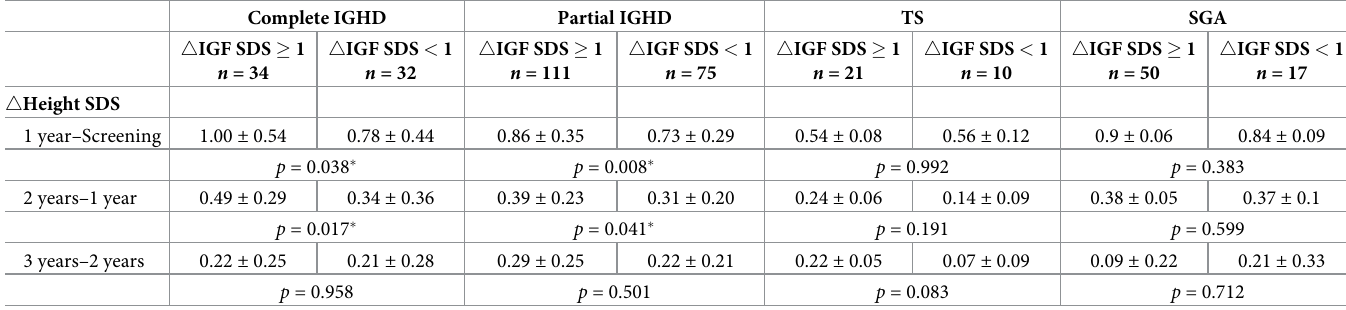
Table 4. Height response group by 4 IGF-1